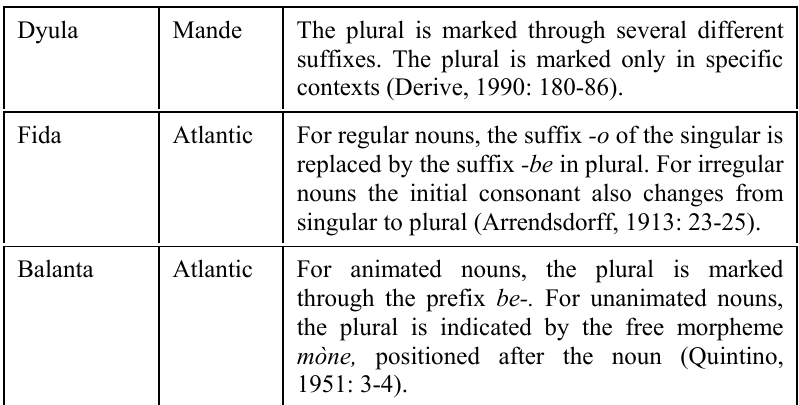
Table IV: in the variationist analyses regarding Copacabana and São Tomé samples, the variable education level was selected in first place and in Nova Iguaçu in